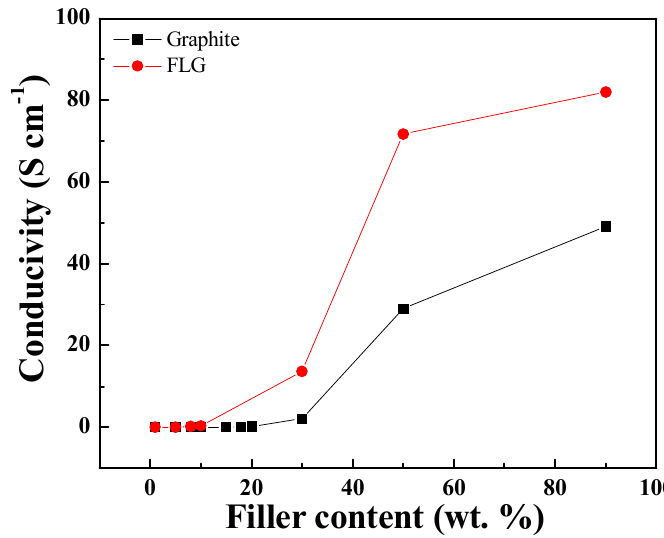
Figure 3. Electronic conductivity of graphite/PVDF and FLG/PVDF composite films measured by a four-point probe.